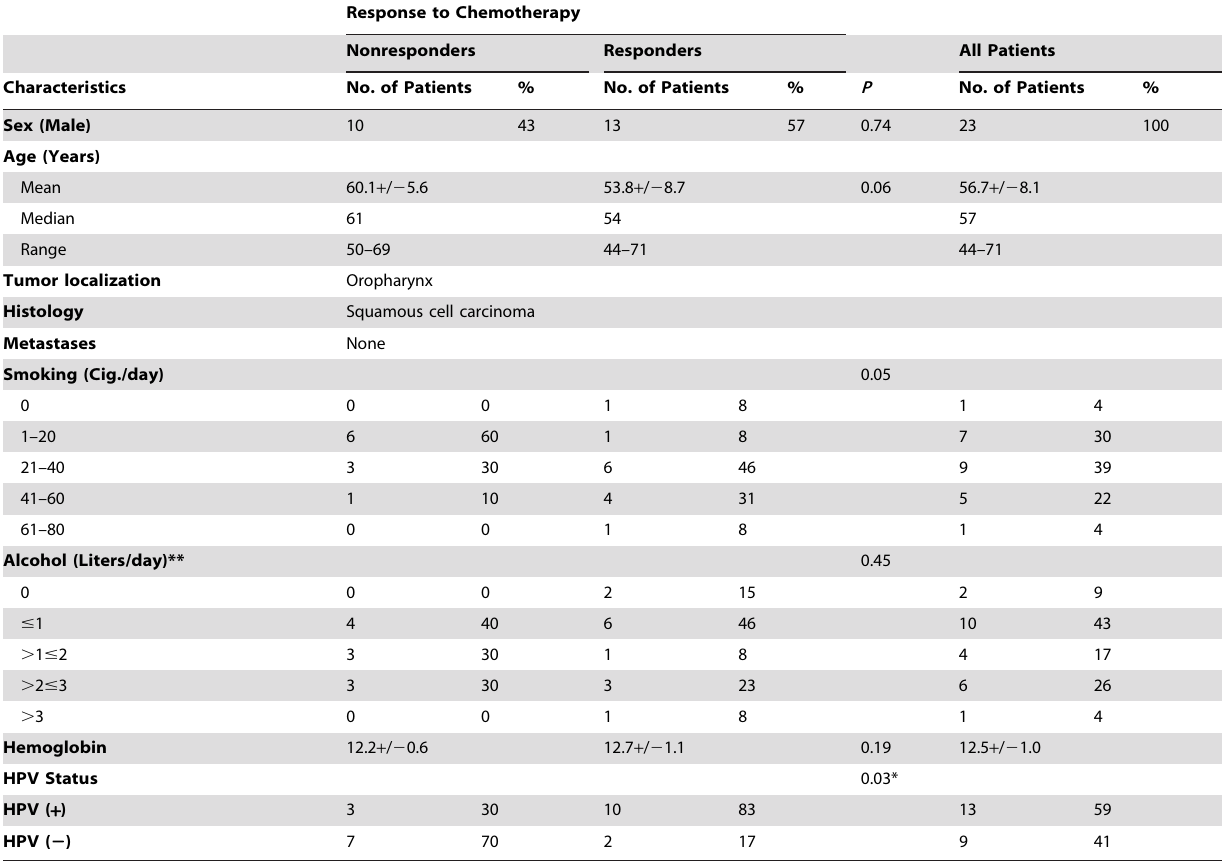
Table 2. Characteristics of Patients (Microarray